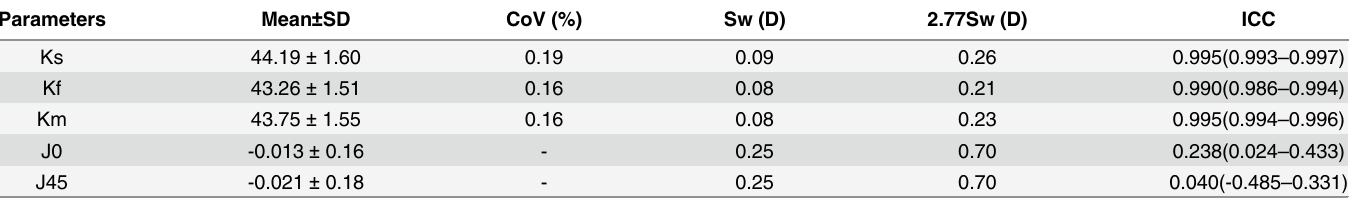
Table 3. The intersession reproducibility of Ks, Kf, Km, J0 and J45 obtained by Topcon KR-1W. (Note: D: diopter, SD: standard deviation, Sw: within- subject standard deviation, CoV: within-subject coefficient of variation, ICC: intraclass correlation coefficient.) Parameters